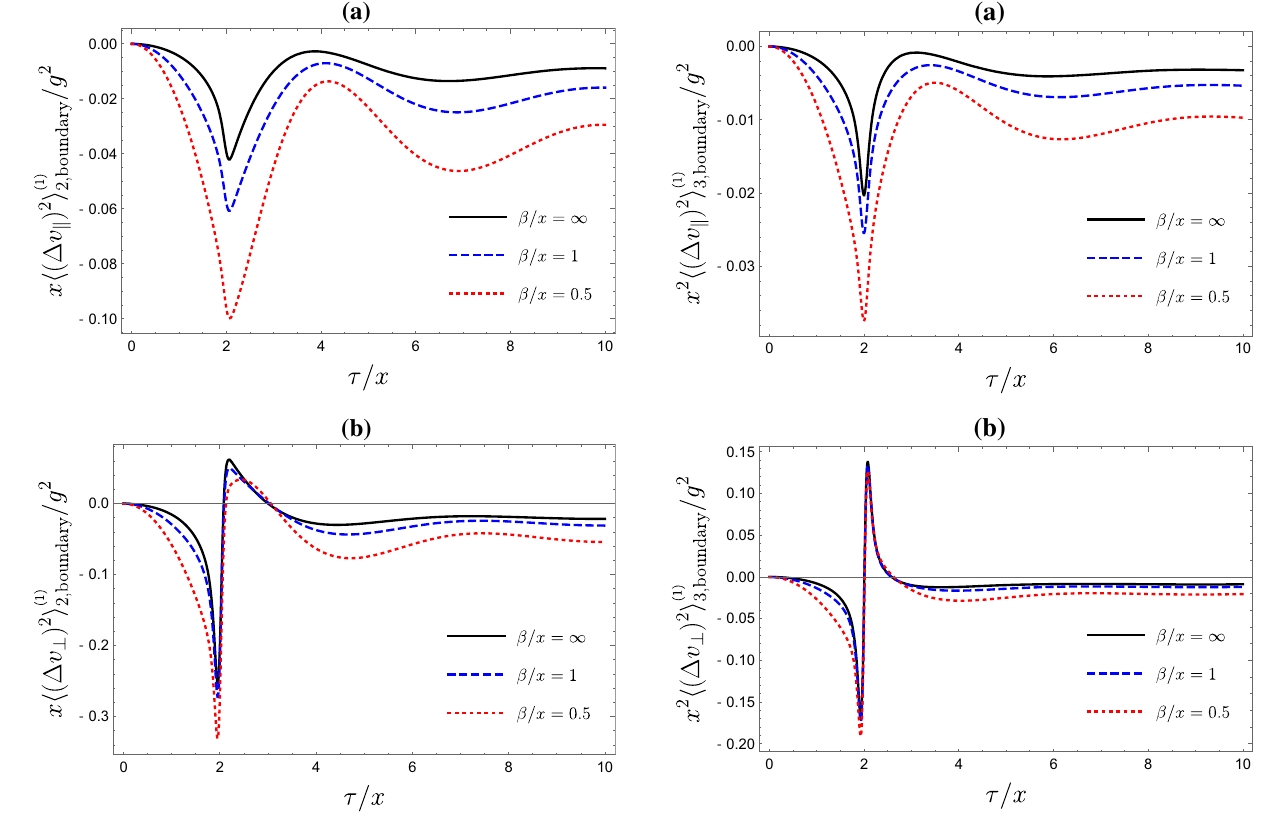
Fig. 3 Dispersioncausedbyareflectiveboundary atfinitetemperature for D = 2. We set n = 20 and mx = 1. a Velocity dispersions in the parallel direction. b Velocity dispersions in the perpendicular direction. It can be seen that the magnitude of the dispersions increases with the